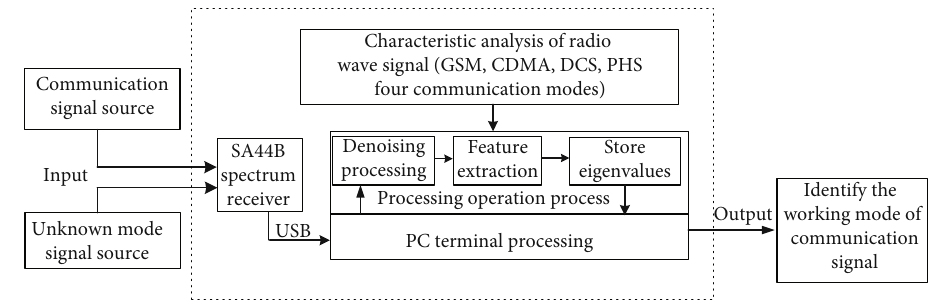
Figure 1: Structure diagram of signal acquisition and identi fi cation system.